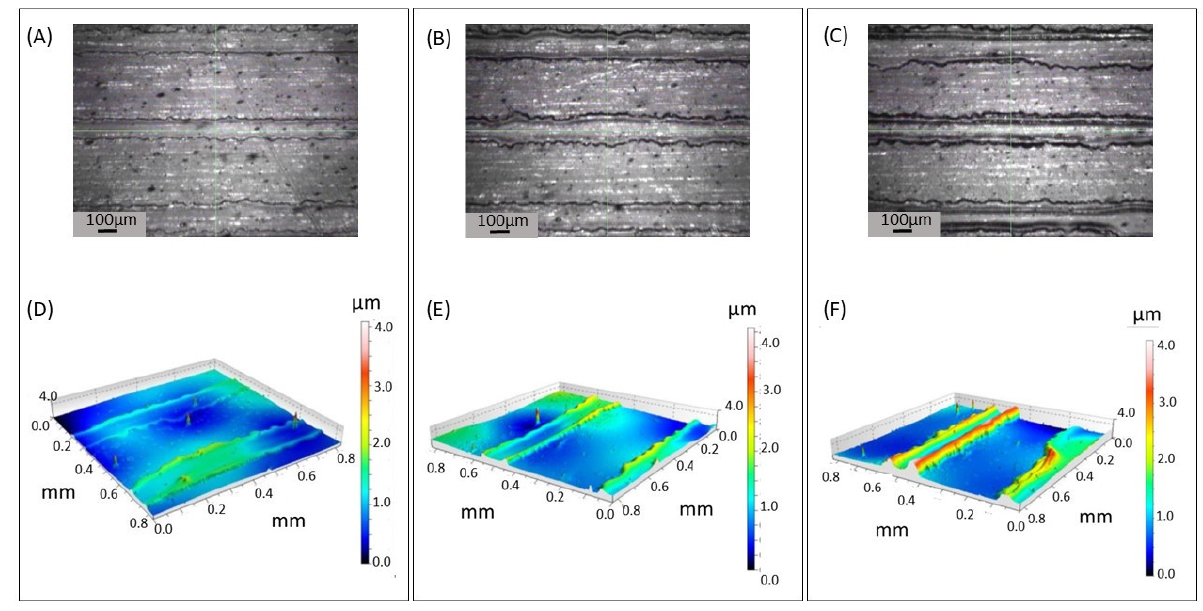
Figure 2. Optical microscopies ( A – C ) and optical profiles ( D – F ) of the PVA surface arrays printed onto PLA substrates, obtained by fixing the drop space and the nozzle number (DS = 15 μm; 4 nozzles) and by changing the number of overlapped layers: 1 layer ( A , D ), 3 layers ( B , E ), 4 layers ( C , F ).